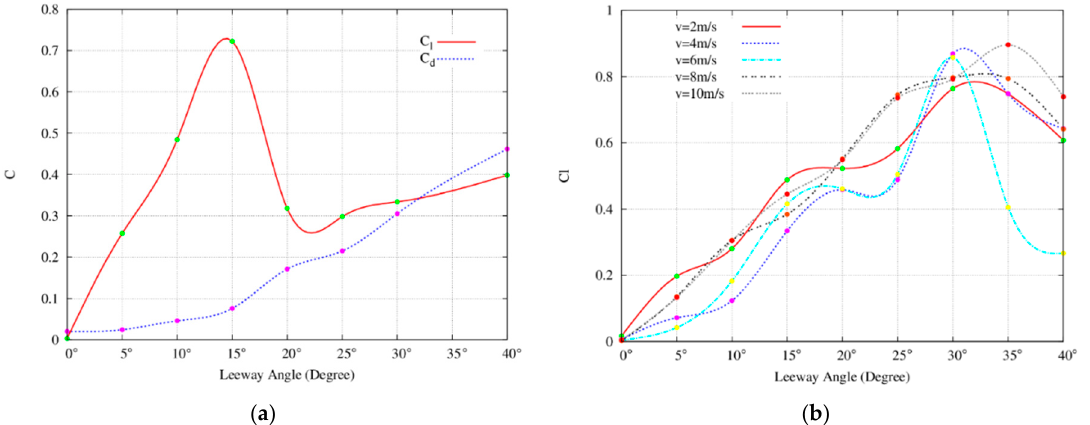
Figure 6. The relationship between the coefficient of force and leeway angle: ( a ) is naked rudder and ( b ) [11] is rudder on the